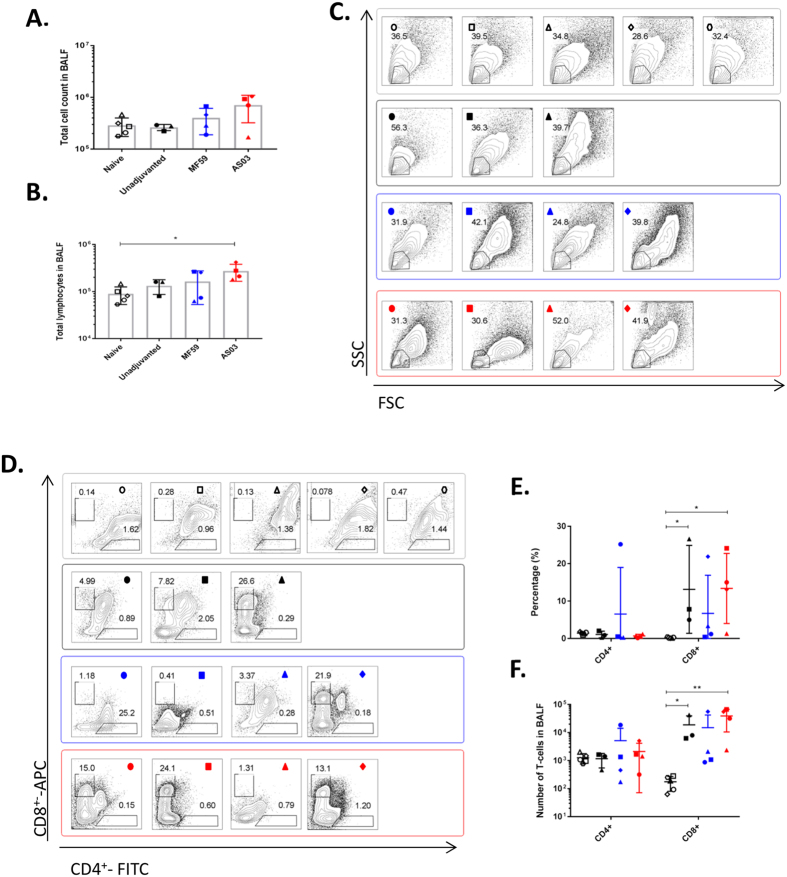
T-cell responses in the bronchoalveolar lavage fluid (BALF) at time of euthanasia or on day 7 post-challenge with wild-type A/Viet Nam/1203/2004 (H5N1). (A) Total cell infiltrate in the BALF. (B) Total number of lymphocytes in the BALF. (C) Flow plots showing the lymphocyte gates with the population frequency as indicated for each ferret, described in Fig. 1. This value was used to derive the absolute numbers in (B). (D) Flow plots to identify CD4+ and CD8+ T-cells in the BALF, with the respective frequencies as indicated. (E) Percentages and (F) absolute cell numbers of CD4+ and CD8+ T-cells in the BALF. All data are presented as group means and error bars represent ± standard deviation. * p < 0.05, ** p < 0.01 by Kruskal-Wallis test, followed by Dunn’s multiple comparison tests. Individual ferrets are assigned its respective symbol within its vaccine group (colored as ○ for naïve, ● for unadjuvanted,  for MF59 and  for AS03).